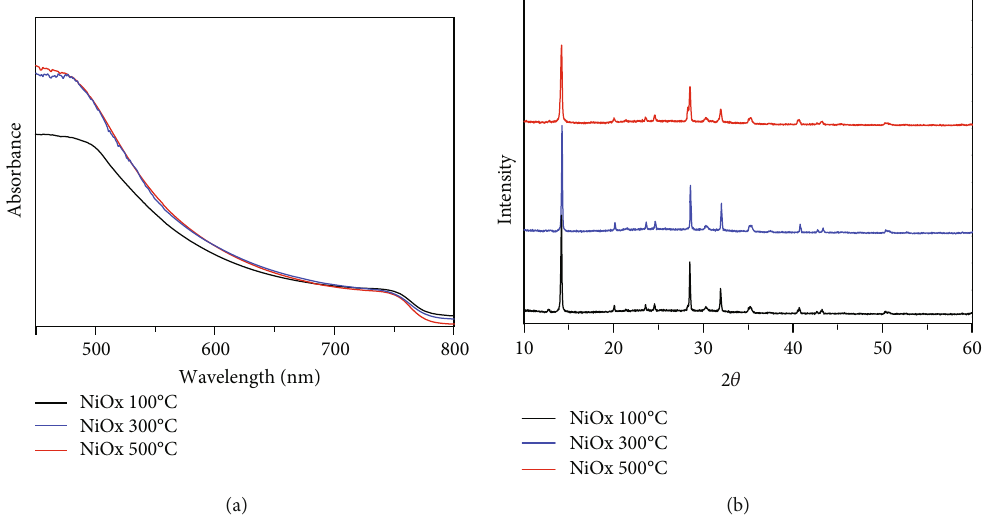
Figure 3: The UV absorption pro fi les (a) and XRD patterns (b) of perovskite fi lms deposited on NiOx annealed at 100 ° C, 300 ° C, and 500 ° C.